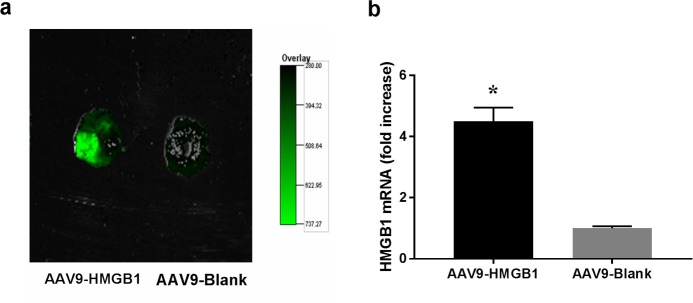
Cardiac-selective overexpression of HMGB1 using AAV9.Intrapericardial injection of AAV9-HMGB1 (conjugated to green fluorescent protein) was performed to induce cardiac-selective HMGB1 overexpression; blank AAV9 (AAV9-Blank) was used as a control. Representative photographs of heart sections from both AAV9-HMGB1 and AAV9-Blank groups are shown in panel (a); mRNA levels of myocardial HMGB1 were quantified using qPCR (b). *p < 0.01 vs. AAV9-Blank.